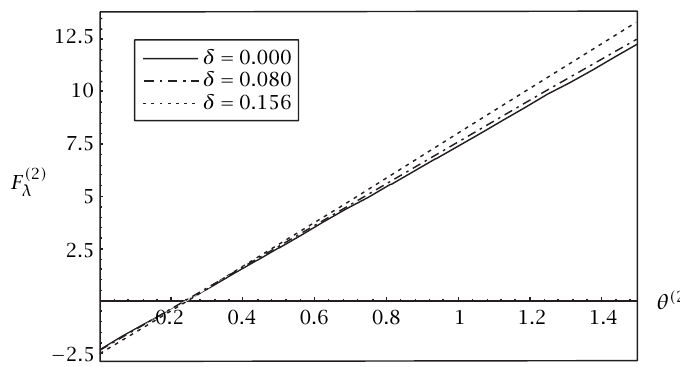
Figure 6.6 . The friction force versus flow rate at Re = 0 . 1, Wi = 0 . 08, and ϕ = 0 . 35.